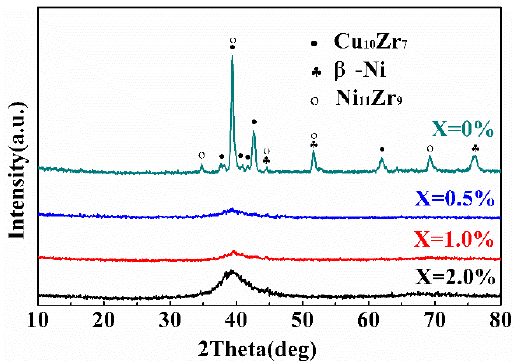
Figure 1. X-ray diffraction (XRD) pattern of the TA–Si x filler metals; x = 0, 0.5, 1.0, and 2.0%.